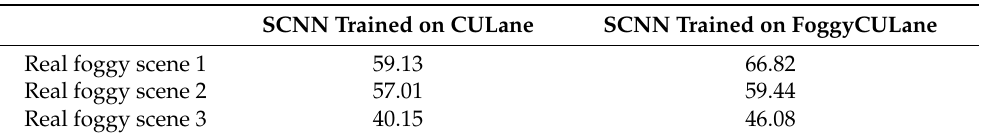
Figure 7. The lane detection results of SCNN tested in real foggy scenes from VIL-100 dataset. Red lines denote the real lane markings and green lines denote the predicted lane markings. Table 5. Lane detection results (F1-measure averaged from 100 images) of SCNN on real foggy scenes from VIL-100 dataset, with the models trained on CULane and FoggyCULane, respectively.